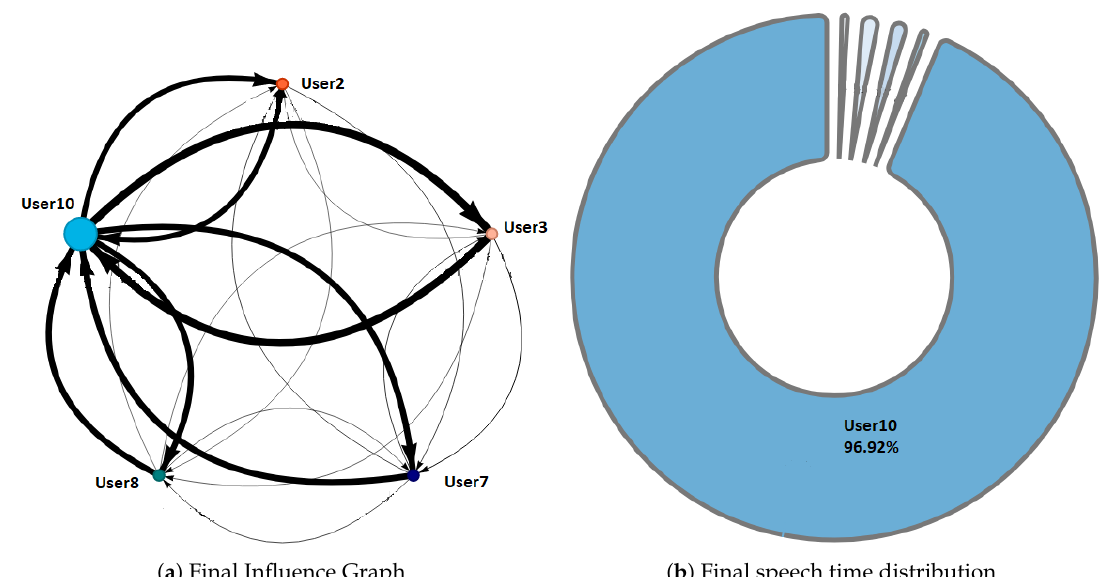
Figure 12. Final Behavior observed in G5.